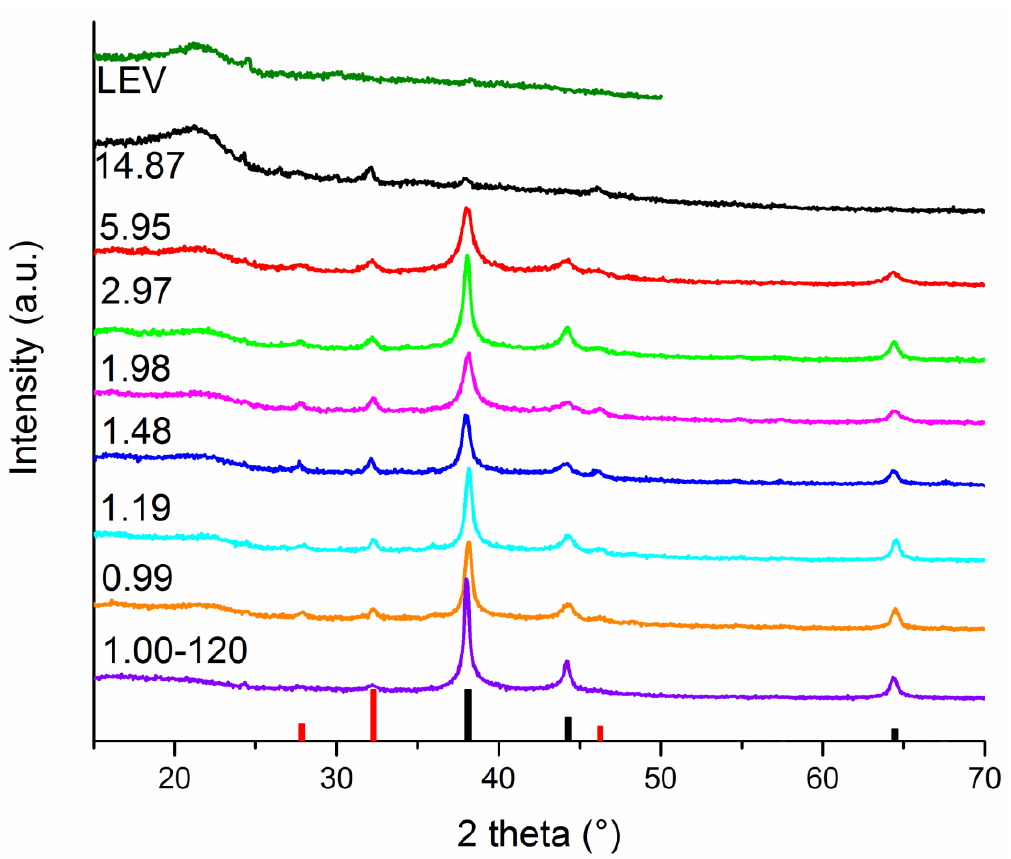
Figure 2. X-ray diffraction (XRD) patterns of all LEV-Ag-MSW (washed samples after mechanochemical synthesis) milled for 15 min after washing. The numbers on the left of each XRD pattern correspond to lavender:AgNO 3 (L:A) mass ratio. The XRD pattern of pure lavender plant ( Lavandula angustifolia L., LEV) is also provided. At the bottom, red bars correspond to cubic AgCl (ICDD 71-5209) and black to cubic Ag (ICDD 65-2871).